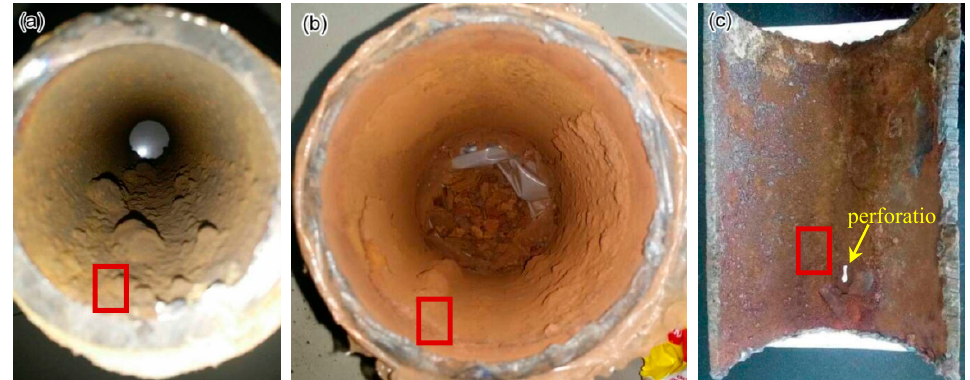
Figure 2. Corrosion morphology on the internal walls of steel pipe sections: ( a ) 2 ″ pipe, ( b ) 4 ″ pipe and ( c ) 6 ″ pipe.